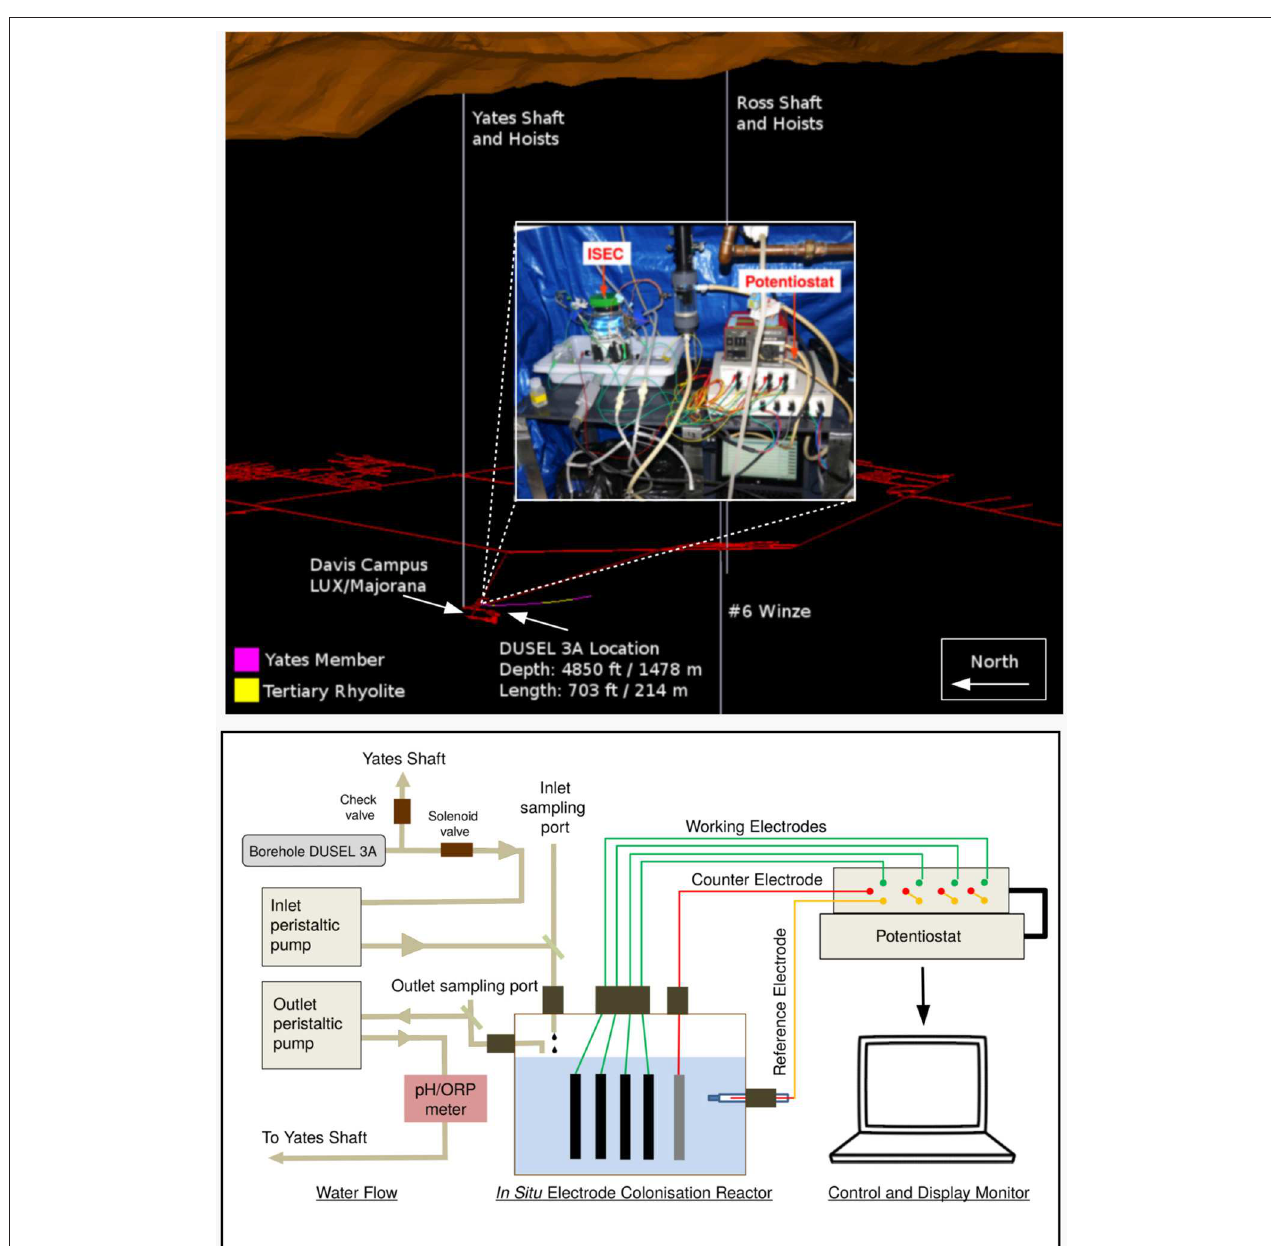
FIGURE 1 | (Top) A 3-dimensional layout of Sanford Underground Research Facility (image to scale). DUSEL 3A, located at 4,850 ft level close to Davis Campus cutting the iron-rich Precambrian Yates member, was selected as the site for in situ electrochemical colonization (ISEC) reactor deployment. An image of the ISEC reactor after deployment (Dec 2014) is shown in the inset. (Bottom) Schematic diagram of ISEC reactor. The four carbon cloth working electrodes were poised at − 0.19, + 0.01, + 0.26, and + 0.53V vs. SHE, respectively, using a 4-channel potentiostat acting as electron donors and acceptors in a single reactor. DUSEL 3A fluid was fed directly into the reactor and the effluent was pumped out to Yates shaft.